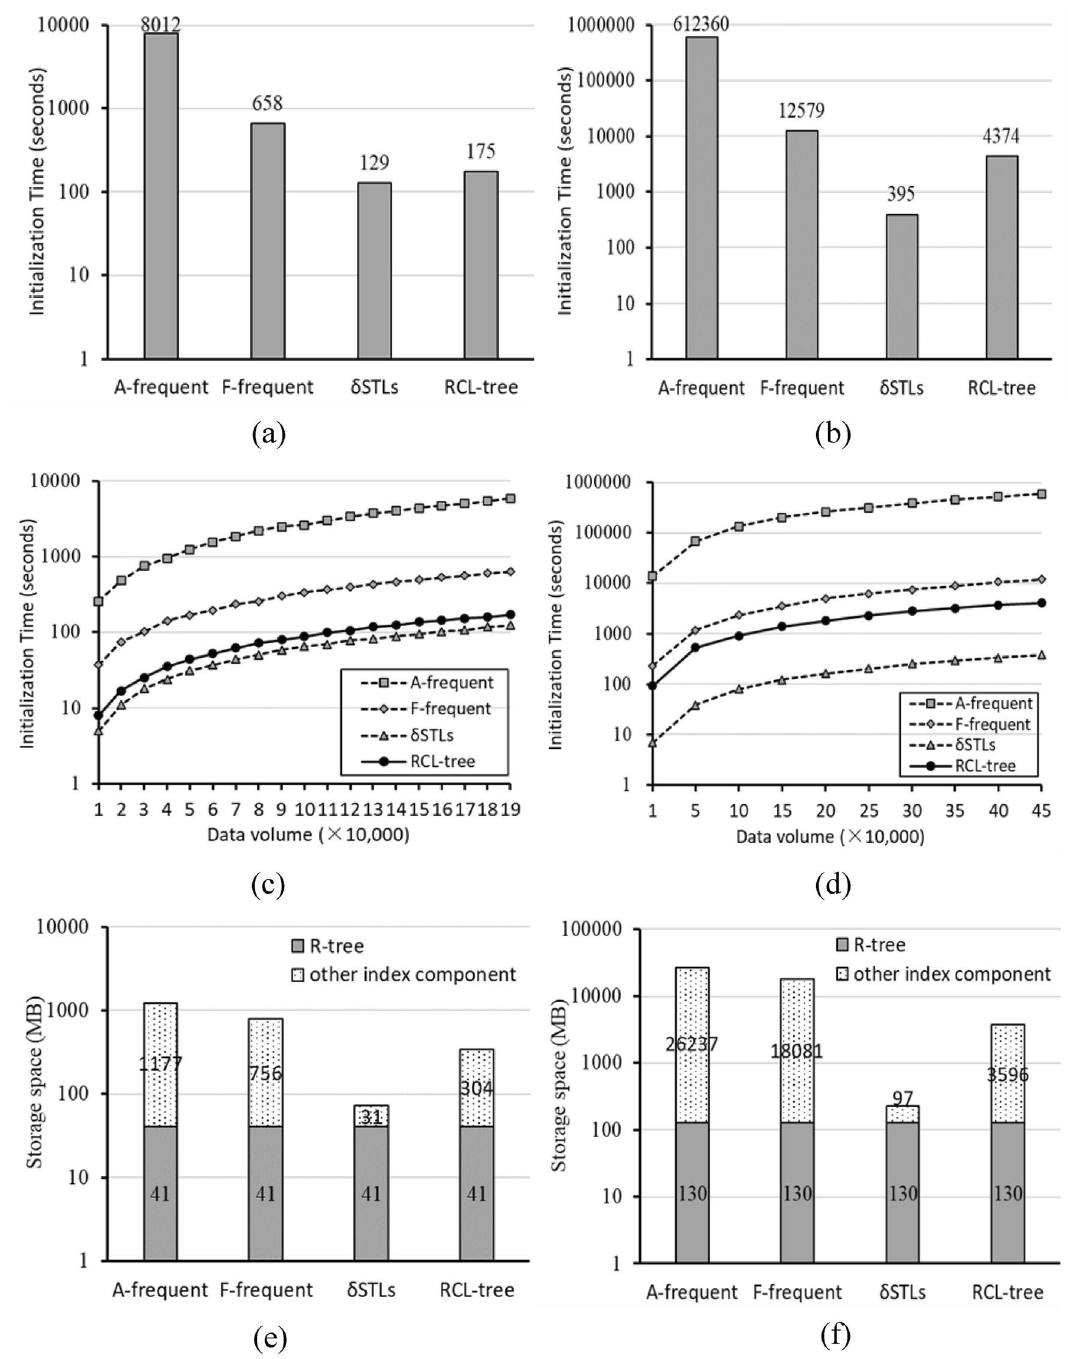
Figure 6. The comparison of initialization. ( a ) I Yelp initialization time, ( b ) I Amap initialization time, ( c ) Effect of varying data volume for I Yelp , ( d ) Effect of varying data volume for I Amap , ( e ) the comparison of storage space in Yelp, ( f ) the comparison of storage space in